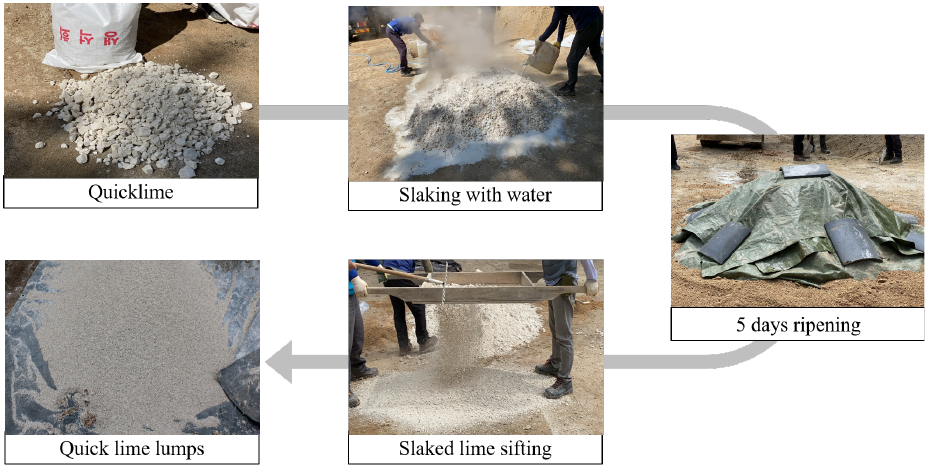
Figure 3. The quick lime lumps production